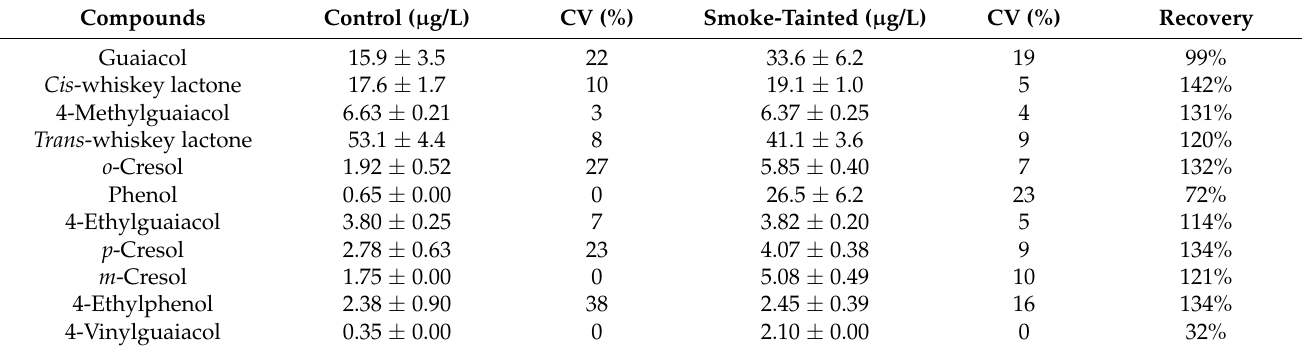
Table 2. Quantification results of smoke-tainted wine and control wine, CV and